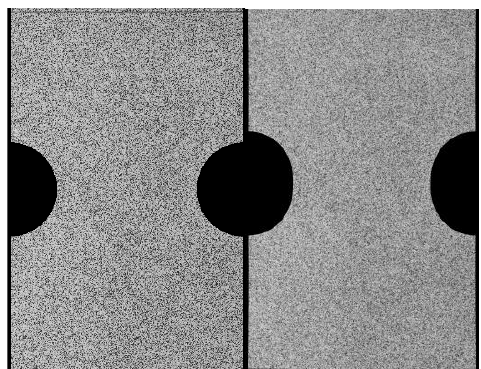
Fig. 4. Synthetic images of a tensile test on a deep-notched specimen (initial and deformed stages) simulating images with spatial resolution of 4320 x 2868 pixels